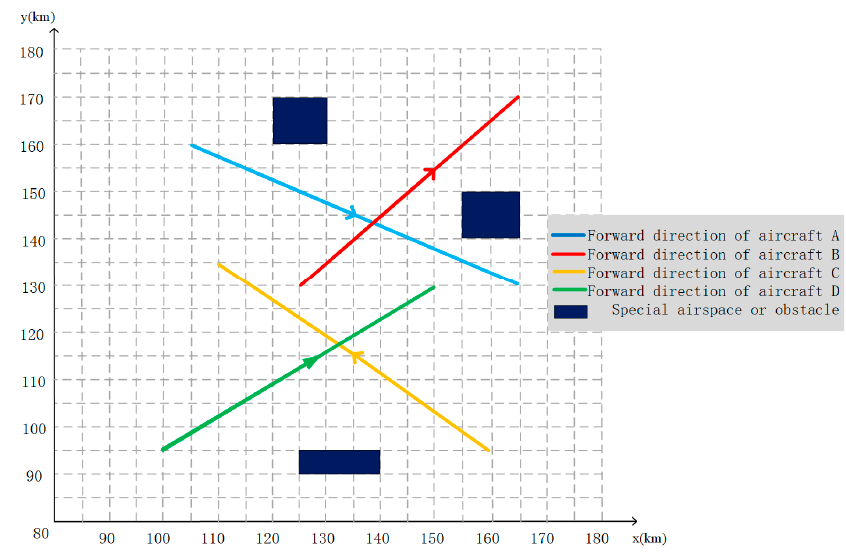
Figure 10. Simplified chart of aircrafts, special airspace, and temporary obstacles.